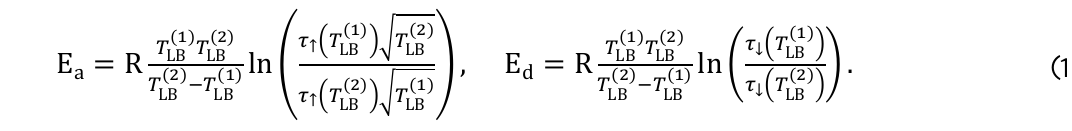
Table 1. Characteristic recovery (τ light bulb temperatures (T